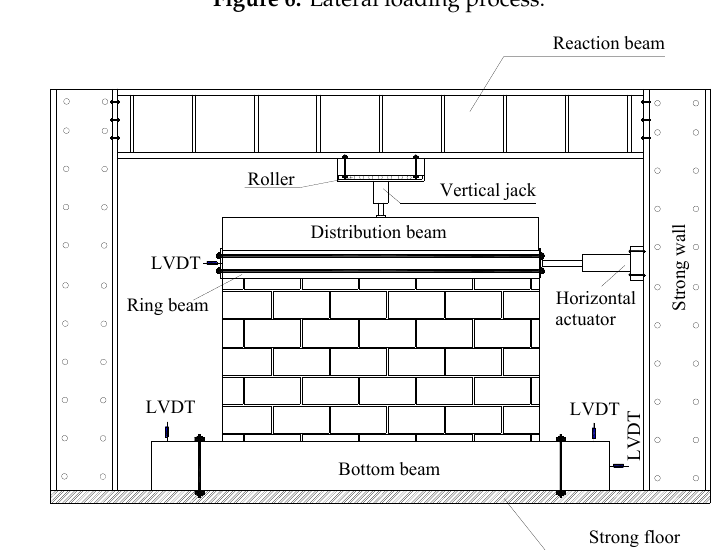
Figure 7. Schematic representation of the test setup.